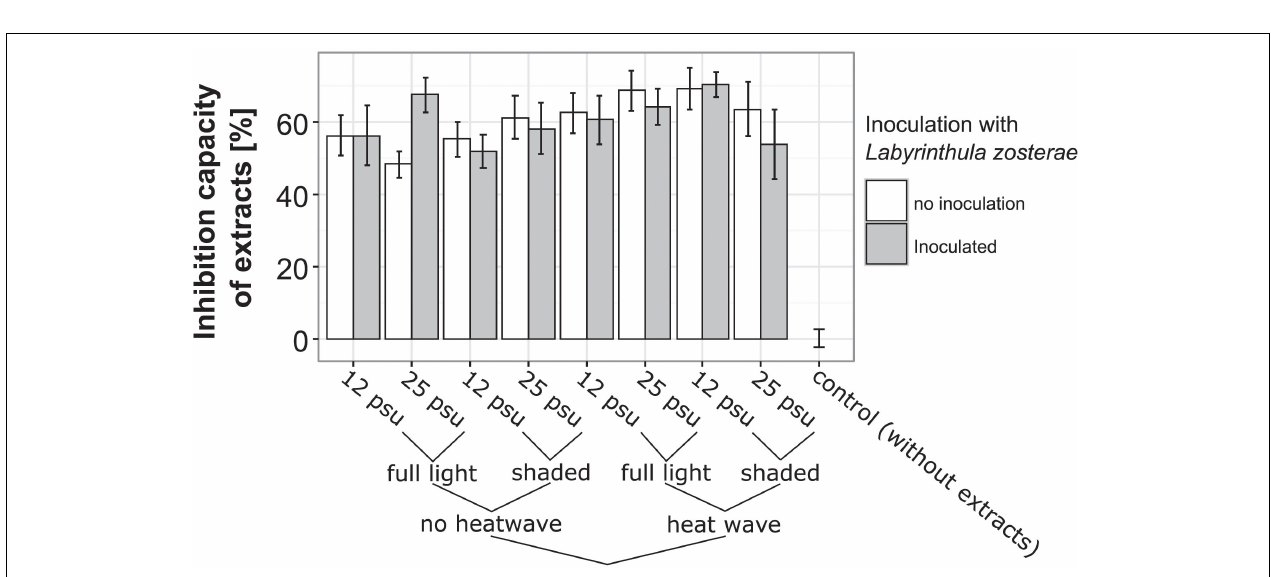
FIGURE 4 | Growth response of eelgrass inoculated by L. zosterae to a combination of abiotic treatments (A) Leaf growth rates of inoculated plants according to the respective stress treatment in cm · d − 1 during the stress treatment. (B) Expansion rate of necrotic lesion in inoculated leaves in cm · d − 1 . (C) Net leaf growth rate was calculated by subtracting the leaf growth rate by lesion expansion rate in cm · d − 1 .